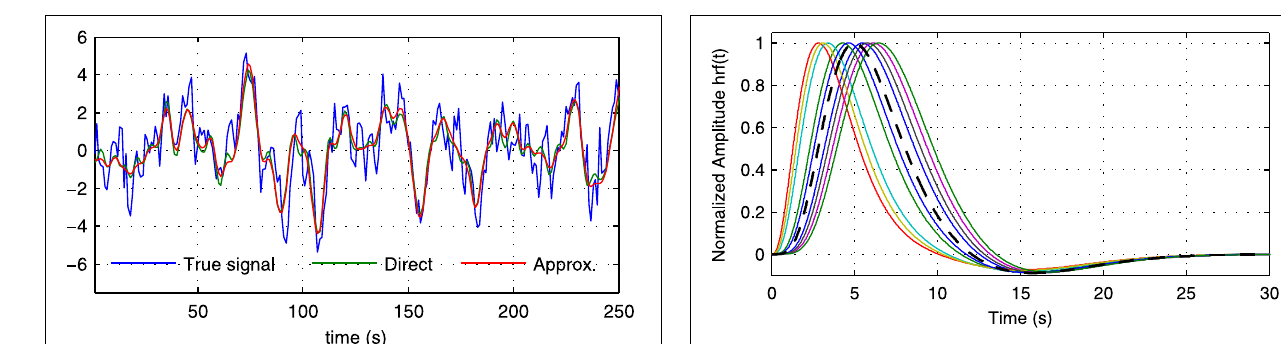
FIGURE 5 | Sections of the true neuronal signal (blue) and estimated neuronal signals for one node in a simulation with N = 5, SNR = 0dB in the first experiment. The neuronal signal estimated by the proposed method is shown in red (“Approx.”), while the neuronal signal estimated by the proposed method without using the approximate time series z ( t ) is shown in green (“Direct”).